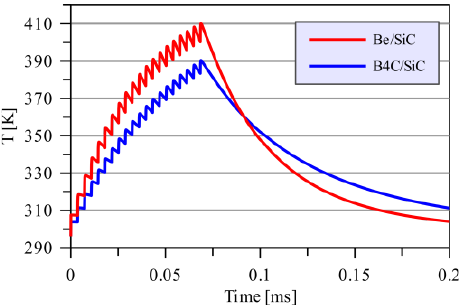
Figure 12. Maximum lens temperature for Be/SiC at 8 keV photon energy and B 4 C/SiC at 17.5 keV for the same absorbed energy of 15.6 µJ per pulse.